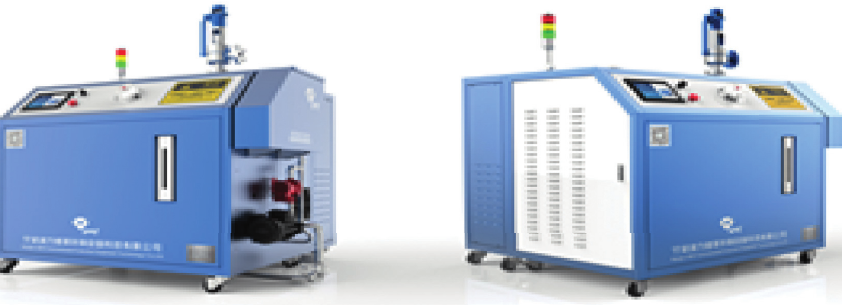
Figure 3: Ultrahigh-temperature steam generator appearance.